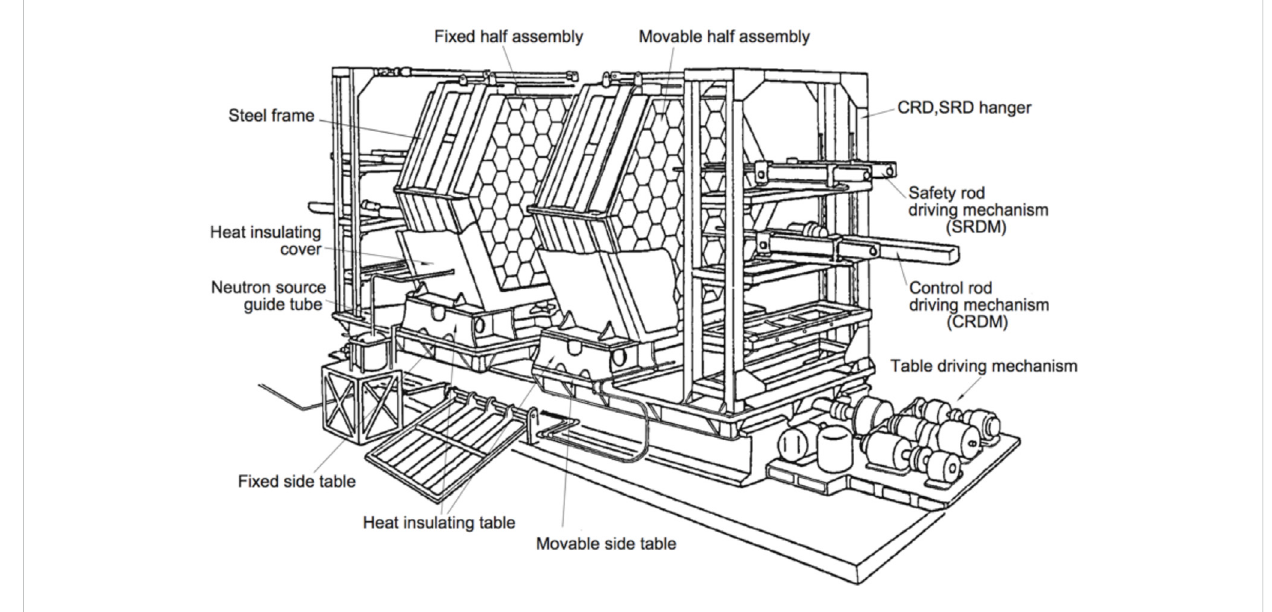
Schematic of VHTRC